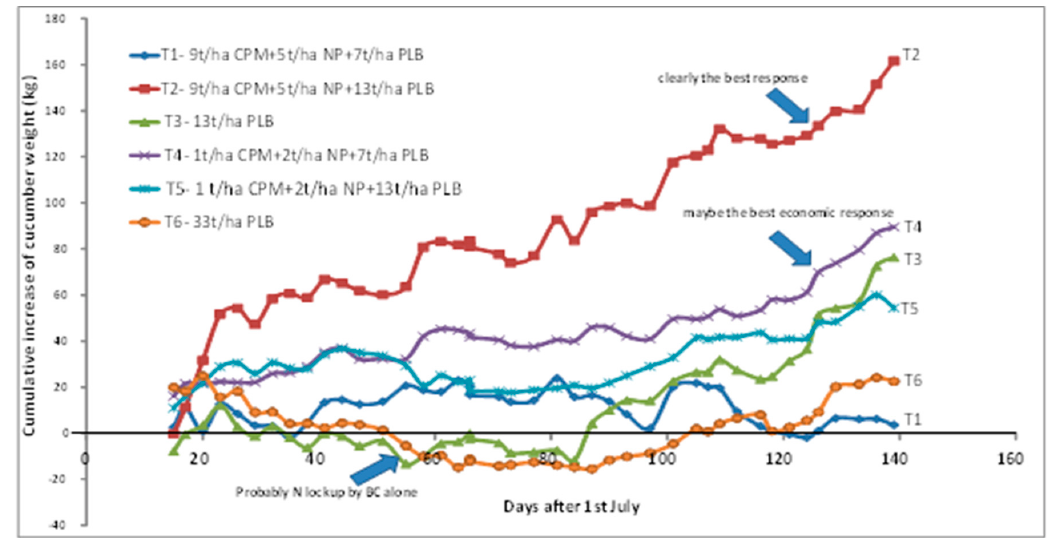
Figure 2. Effect of biochar, fertilizer, and manure on leaf biomass of cucumber. Different letters above the bars suggested that these values are significantly different at p ≤ 0.05.